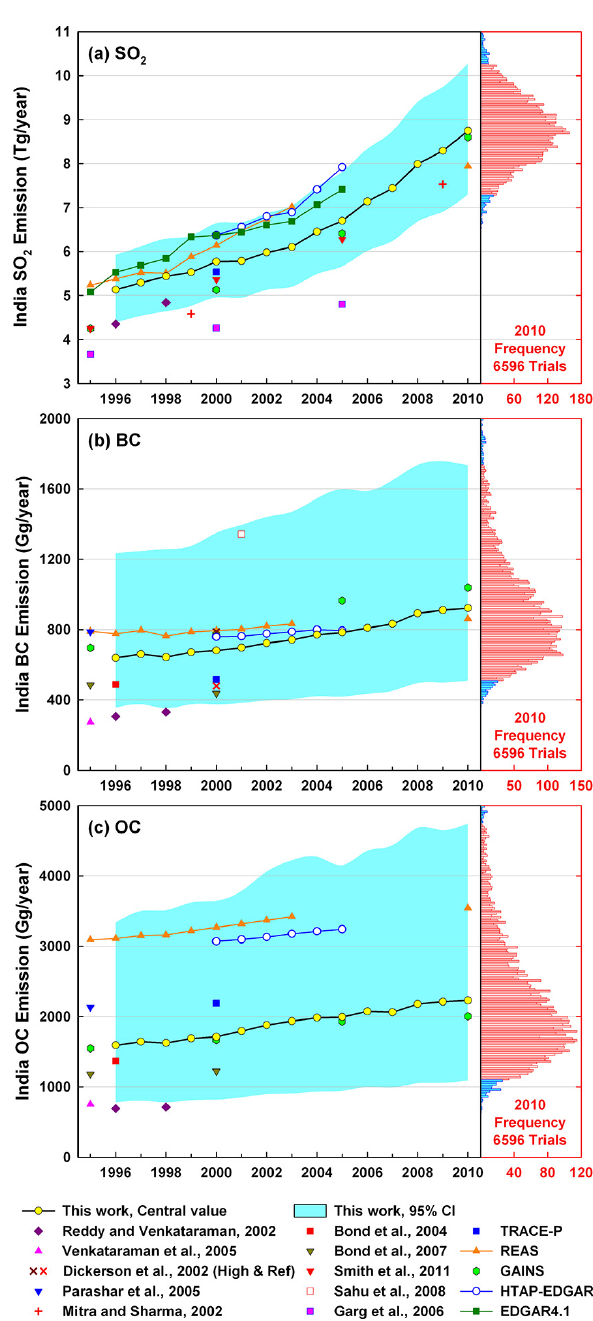
Fig. 5. Comparison of emission estimates (excluding emissions from open biomass burning) for China: (a) SO 2 , (b) BC, and (c) OC. The right subgraphs present the distributions of estimated emis- sions in 2010. The blue bars are beyond the 95% CIs.